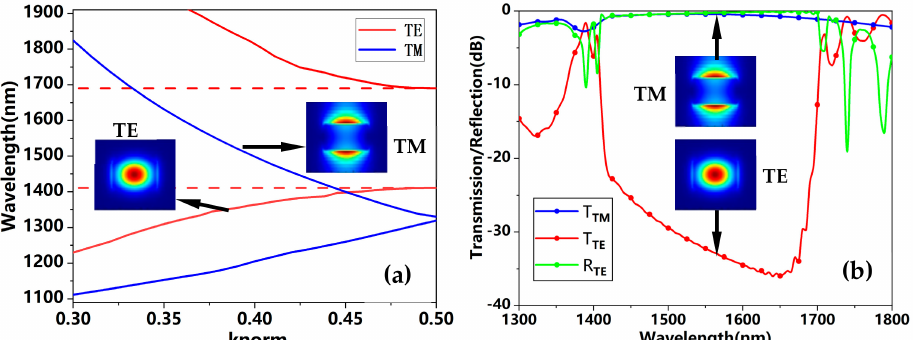
Figure 2. ( a ) The band structure diagram for both TE and TM polarization states; ( b ) The wavelength dependent transmittance and reflectance of TE and TM polarization states under the initialized device geometries. Inset: Mode profiles of TE and TM polarization